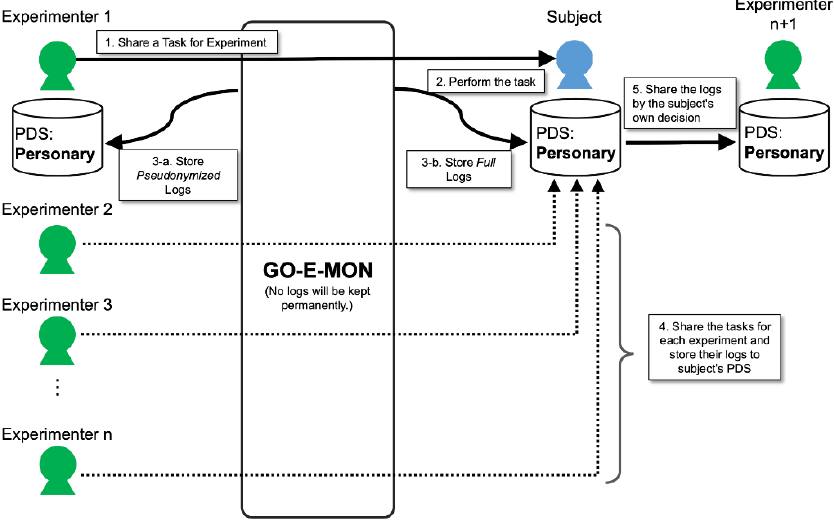
Figure 1. Overview of GO-E-MON: Experimenters can deliver the task to subjects through GO-E- MON. Each experimenter and subject have their own PDS (Personary), and GO-E-MON stores the experimental data in each PDS. Subjects have their own experimental data for the experiments that they have participated in and can provide such data to another experimenter as they please.